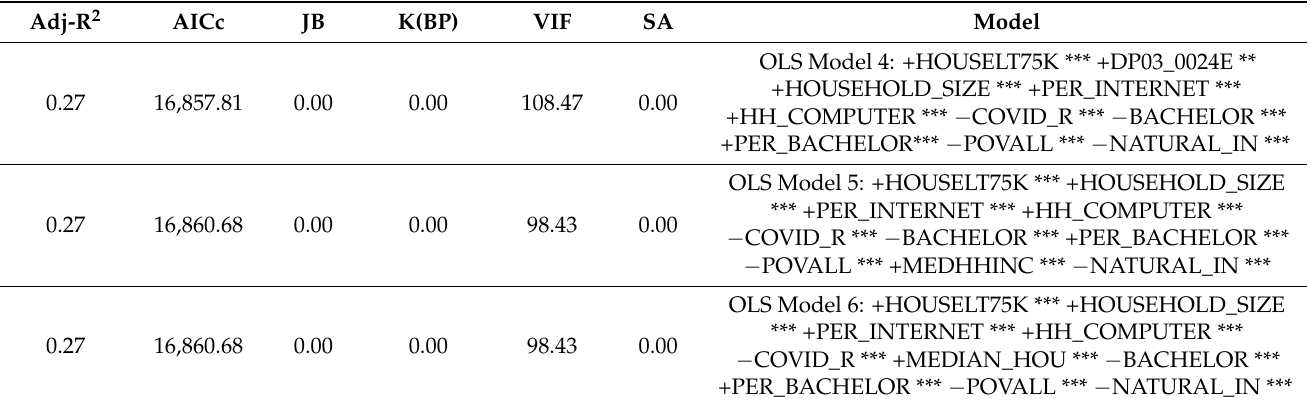
Table Abbreviations: Adj-R 2 —adjusted R-squared; AICc—Akaike’s information criterion; JB—Jarque–Bera p - value; K(BP)—Koenker (BP) statistic p -value; VIF—max variance inflation factor; SA—global Moran’s I p -value;